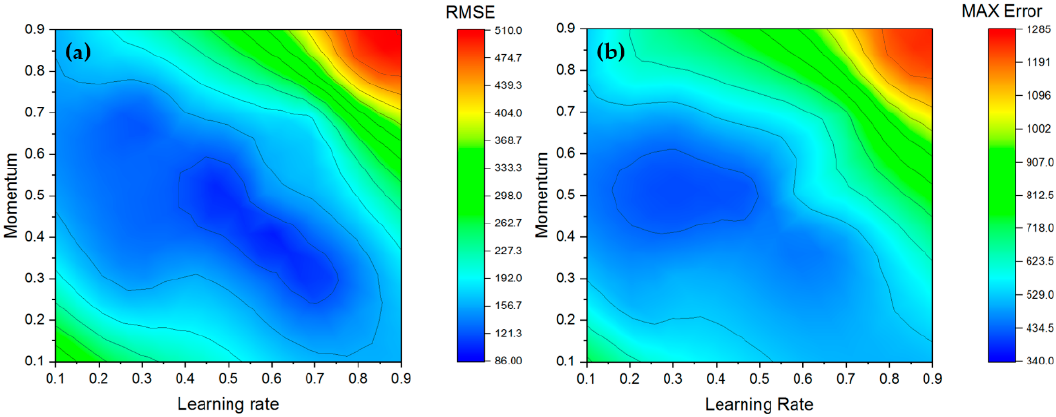
Figure 5. The e ff ect of the learning rate and momentum coe ffi cient on ( a ) Root-mean squared error Figure 5. The effect of the learning rate and momentum coefficient on ( a ) Root-mean squared error (RMSE); ( b ) Maximum error when the architecture of the model is (RMSE); ( b ) Maximum error when the architecture of the model is 10-8-1.